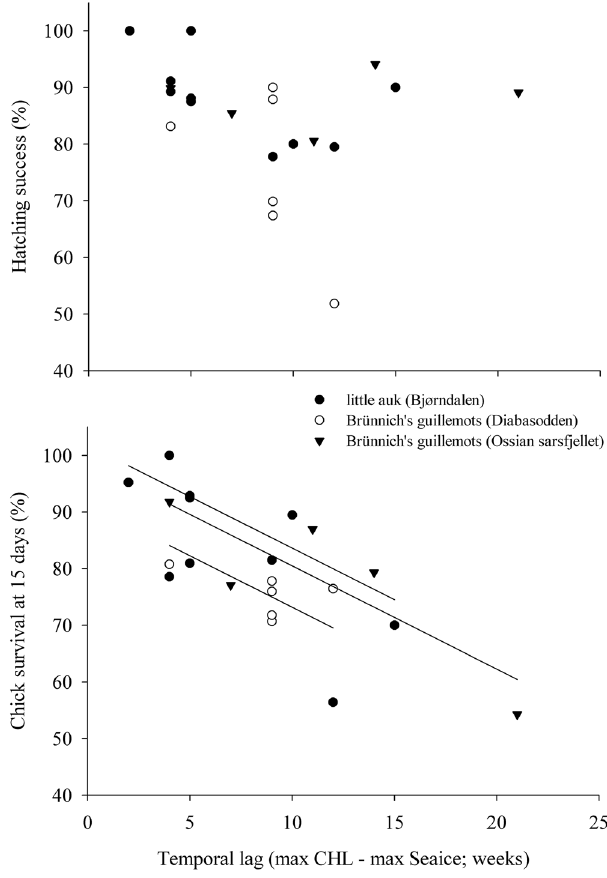
Figure 3. Seabirds’ breeding responses. Brünnich’s guillemot and little auk breeding responses to inter-annual changes in the temporal lag – in weeks – between the annual peaks of sea ice extent and CHL- a